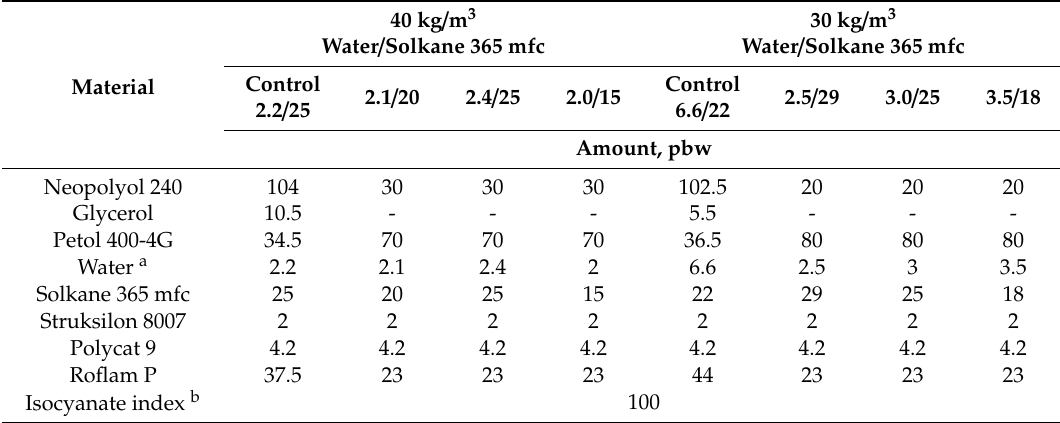
Table 3. Compositions of rigid polyurethane foams with di ff erent apparent